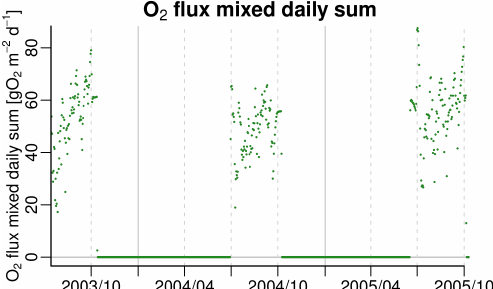
Figure B4. Modelled oxygen flux into soil in a mixed approach of 65% rim plus 35% centre as the daily sum. Solid lines indicate 1 January; dashed lines indicate 1 April, 1 July and 1 October of the respective year. The range of the modelled values is − 0 . 00184 to 87.6g O 2 m − 2 d − 1 .